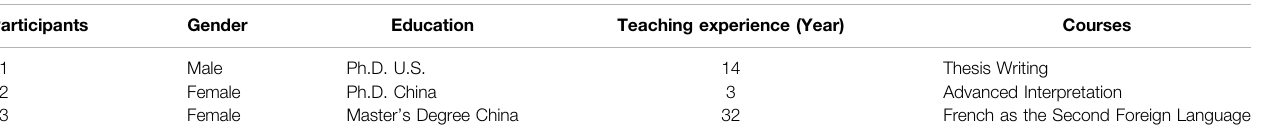
TABLE 1 | Basic information of